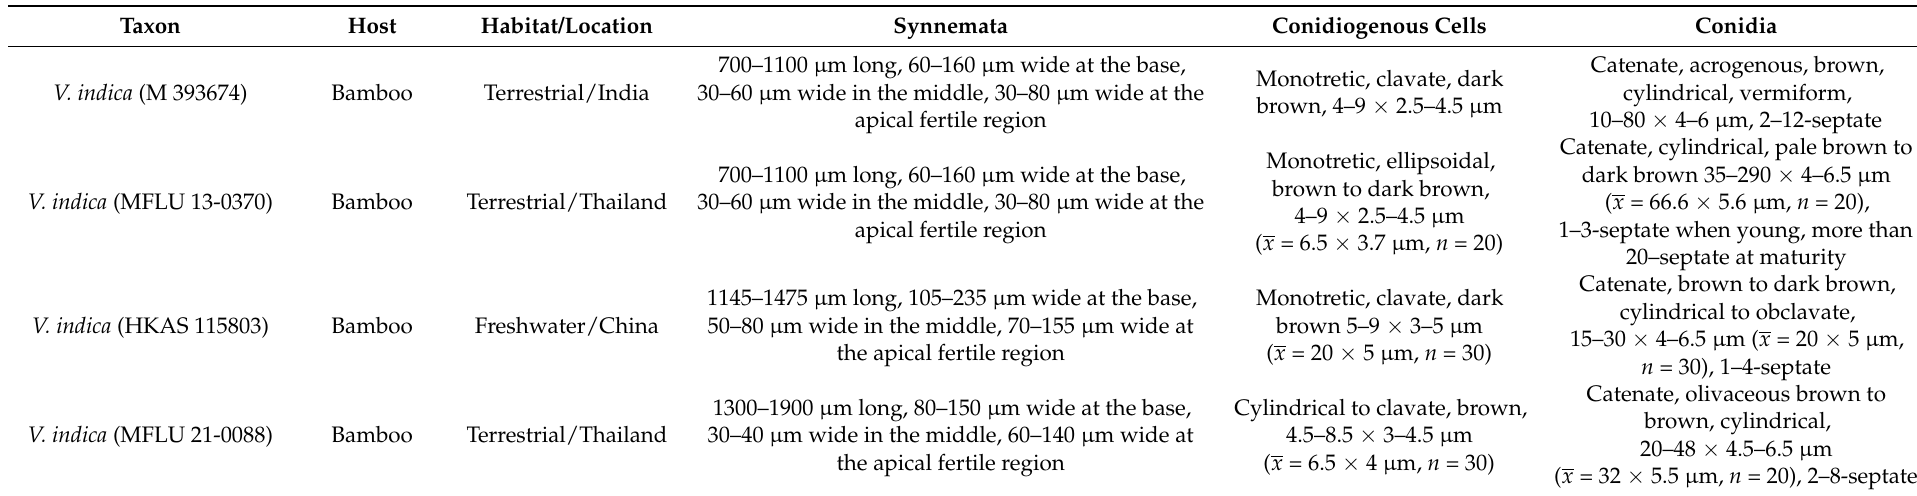
Table 3. Synopsis of characters of Vamsapriya indica